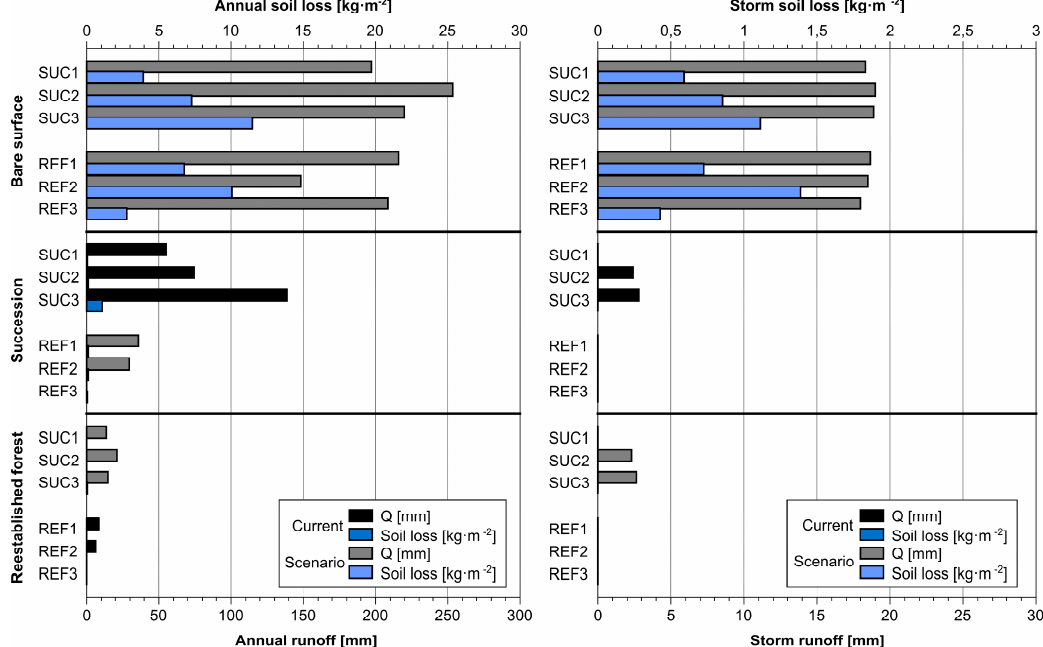
Figure 15. Modeling results (annual and storm) for (FOR)ested and (CUT)-down sites, using realistic slope geometry and different land managements.